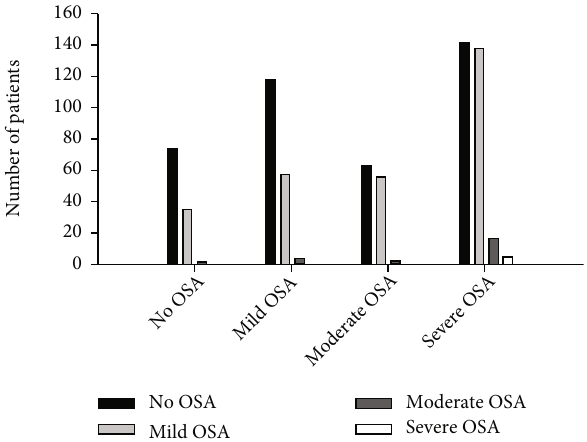
Figure 2: Distribution of central sleep apnea severity in children with sleep disordered breathing is shown. Severity of central sleep apnea (CSA) varied among the patients with no obstructive sleep apnea (OSA), mild OSA, moderate OSA, and severe OSA. Children with no OSA, mild OSA, or moderate OSA did not have severe CSA. Severe CSA occurred in children with severe